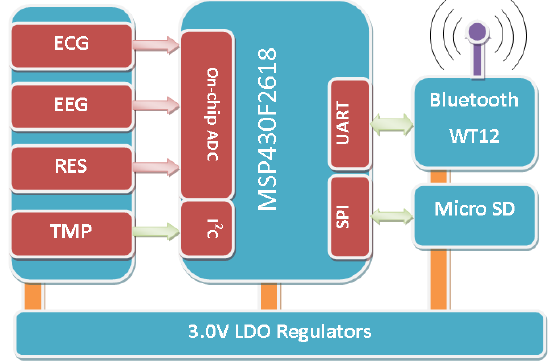
Figure 3. The block diagram of sensor node in